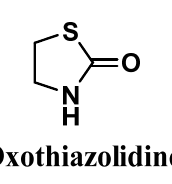
Figure 9. Chemical structure of